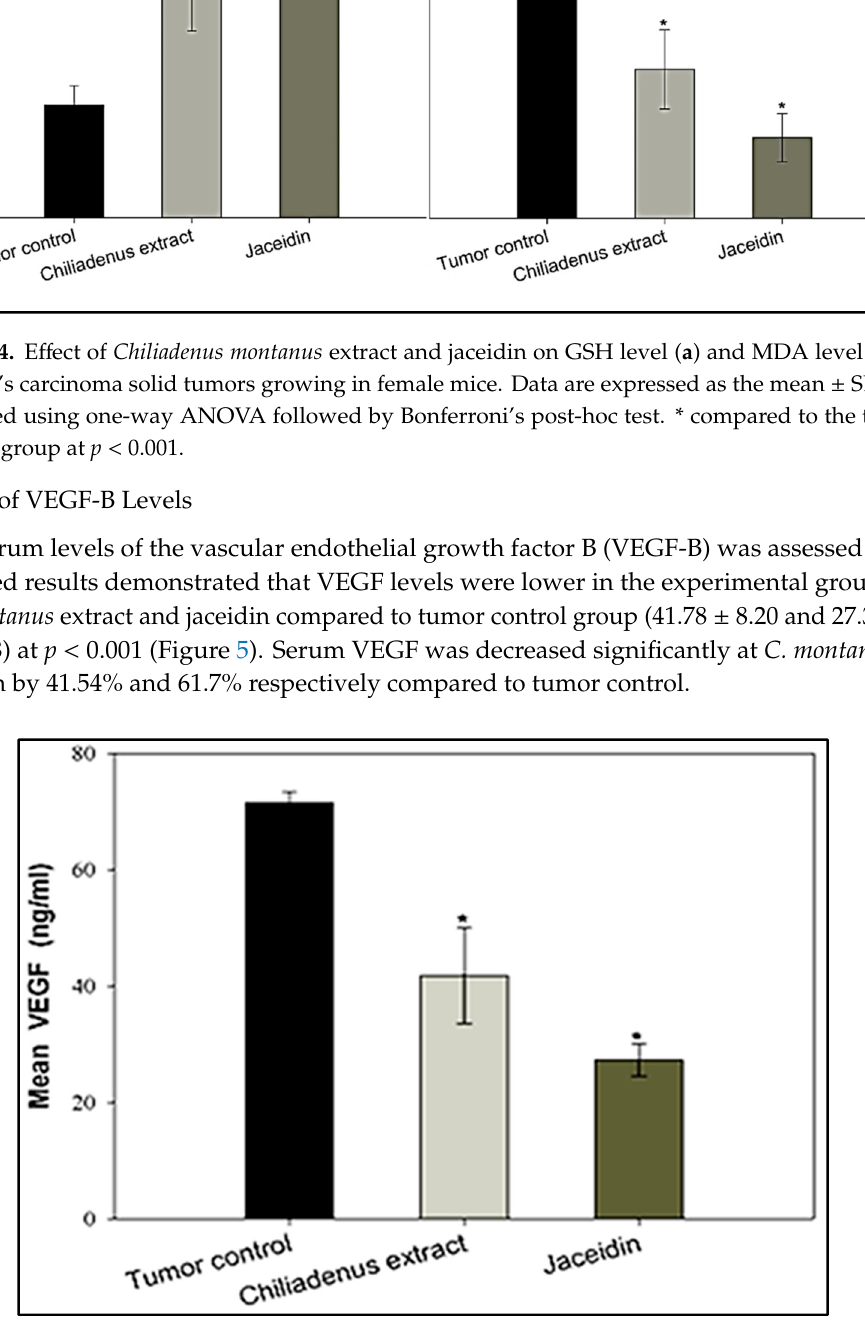
Figure 5. Effect of Chiliadenus montanus extract and jaceidin on serum VEGF level in female mice bearing Ehrlich’s carcinoma solid tumors. VEGF: vascular endothelial growth factor. Data are expressed as the mean ± SD and analyzed using one-way ANOVA followed by Bonferroni’s post-hoc test. * compared to the tumor control group at p < 0.001.